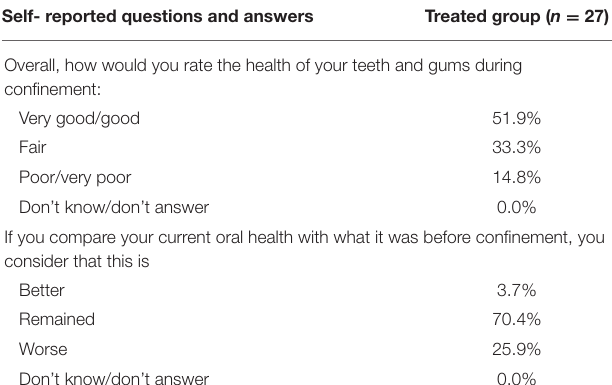
TABLE 3 | Self-reported screening questionnaire, frequency of responses to the self-reported